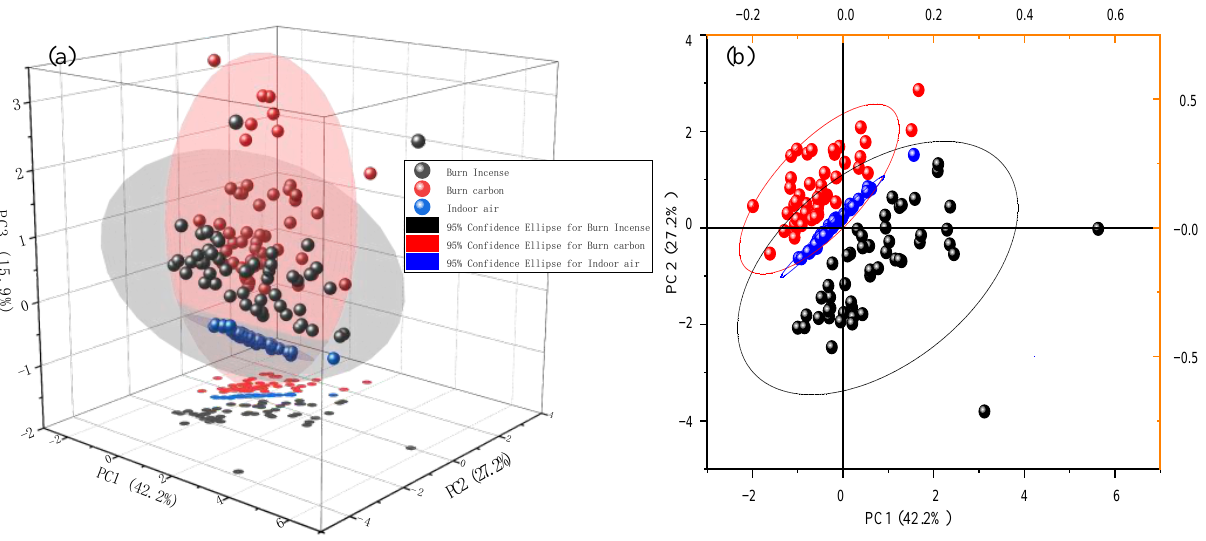
Figure 4. ( a ) The 3D result of PCA including indoor air, burning carbon and burning incense; ( b ) The 2D result of PCA including indoor air, burning carbon and burning incense. Table 3. Partial PC band weights.